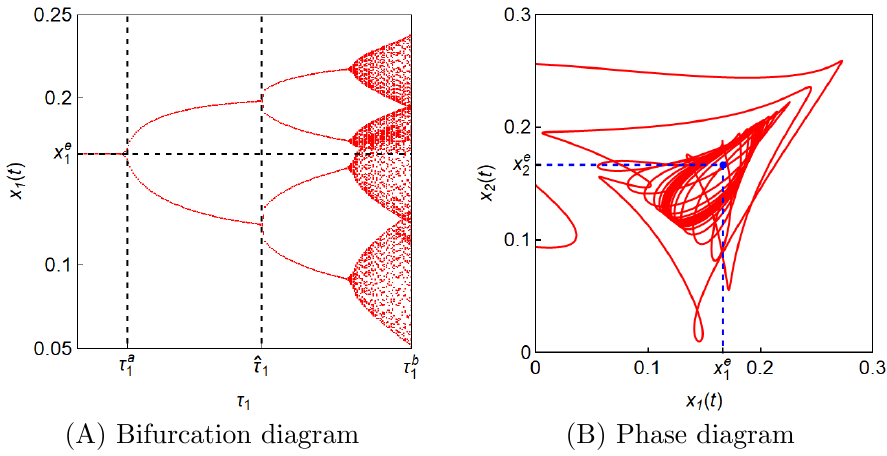
Figure 6. Possible global dynamics for various values of τ 1 < τ c